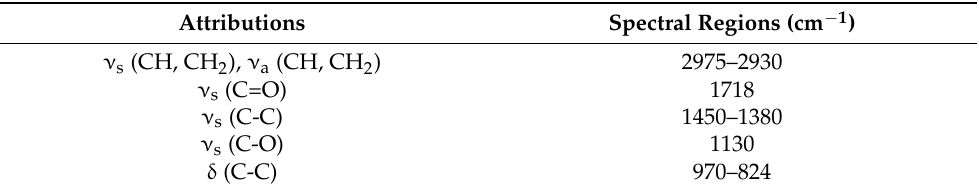
Figure 3. Silver ions release from AgNPs-PHBV composite film in PBS contact solution ( a ); R 2 was equal to 0.9887. Corresponding control experiment on bare PHBV ( b ). The plateau value of silver ions concentration was reached in about 3 h, and resulted equal to 61 ± 3 ppb. Kinetic constant (i.e., b ) was calculated to be 2.8 ± 0.6 h − 1 . Silver ion concentration at time t = 0 (i.e., y 0 ) was 7 ± 2 ppb. The presence of immediately soluble silver species (almost negligible), which are released in PBS as soon as the samples go in contact with the aqueous solution, are probably ascribable to a surface partial oxidation of AgNPs. This phenomenon was already reported for similar composite materials [15,18].